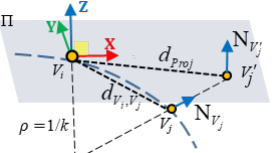
Figure 4. Distance metric considering local curvature